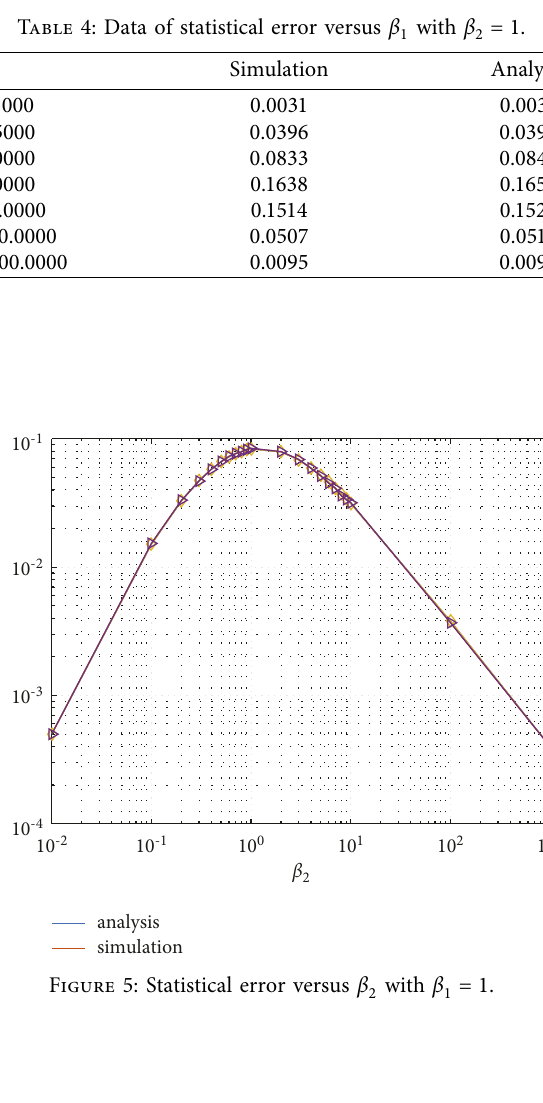
Table 4: Data of statistical error versus β